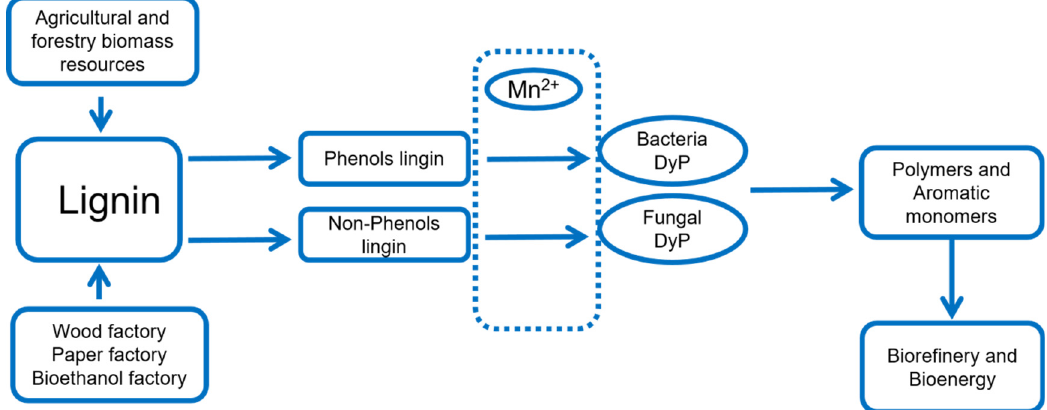
Figure 4. Process graph shows the possible research direction of DyPs in lignin and it shows that bacteria prefer to use phenolic lignin, while fungi prefer non-phenolic lignin.